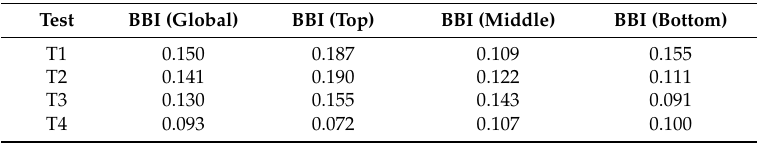
Table 4. Quantification of ballast breakage using the